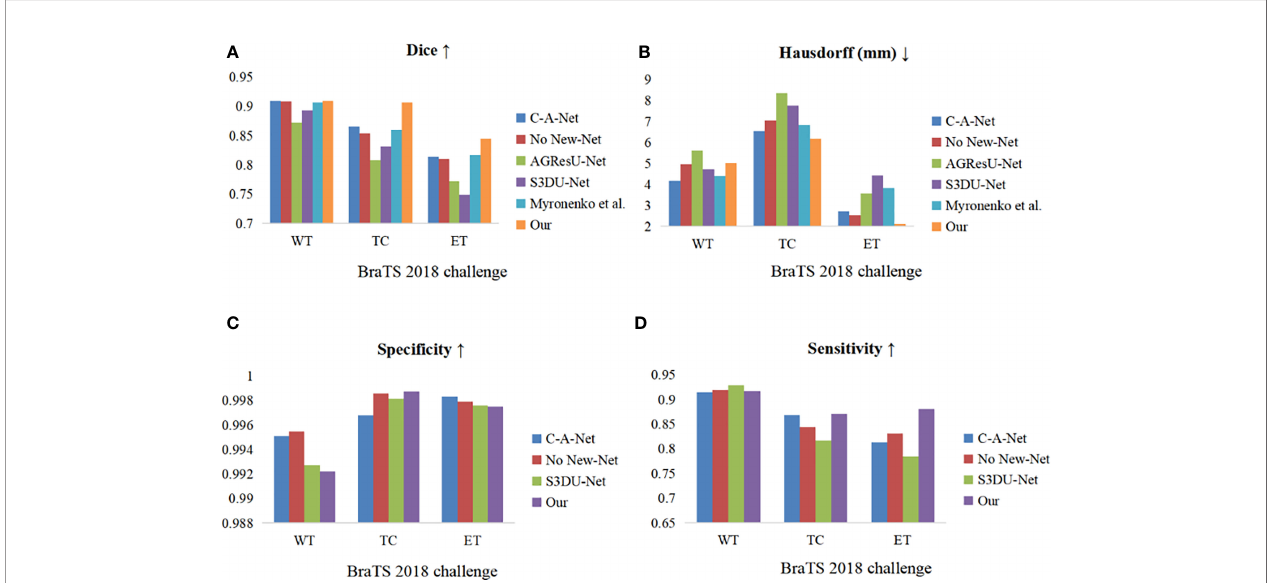
FIGURE 9 | Comparative histograms of evaluation indicators for four methods on the BraTS 2018 validation set. (A – D) Dice, Hausdorff (mm), speci fi city, and sensitivity. The colors correspond to the methods.